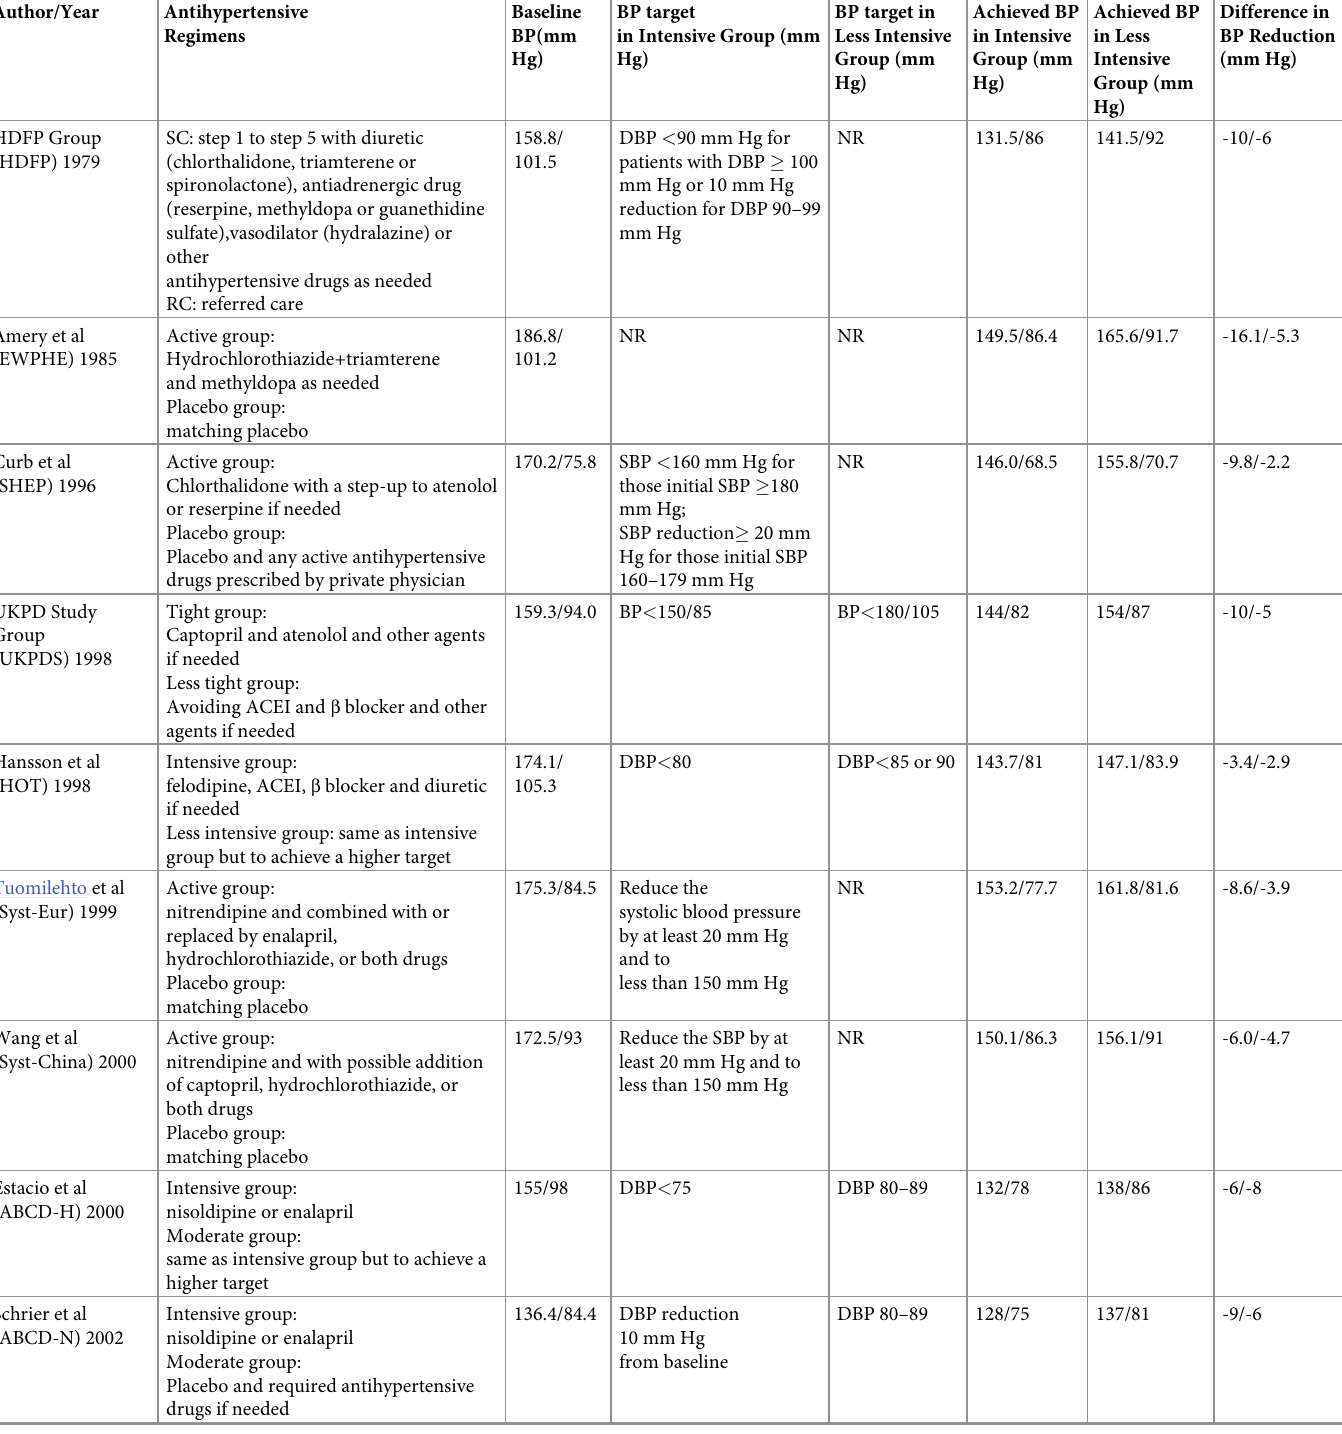
Table 2. Trial interventions and their